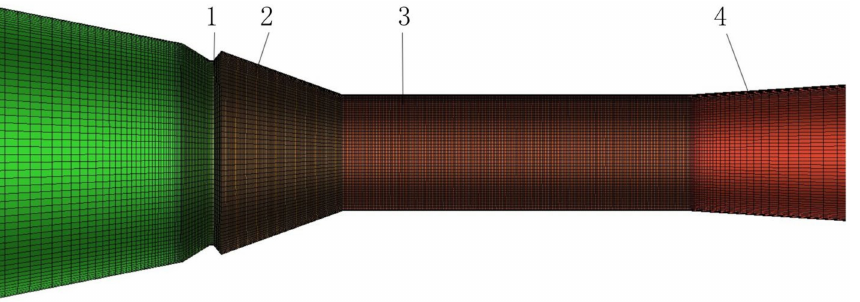
Figure 3. Schematic diagram of local grid refinement. 1-annular nozzle; 2-suction chambers; 3-throat; 4-diffuser.